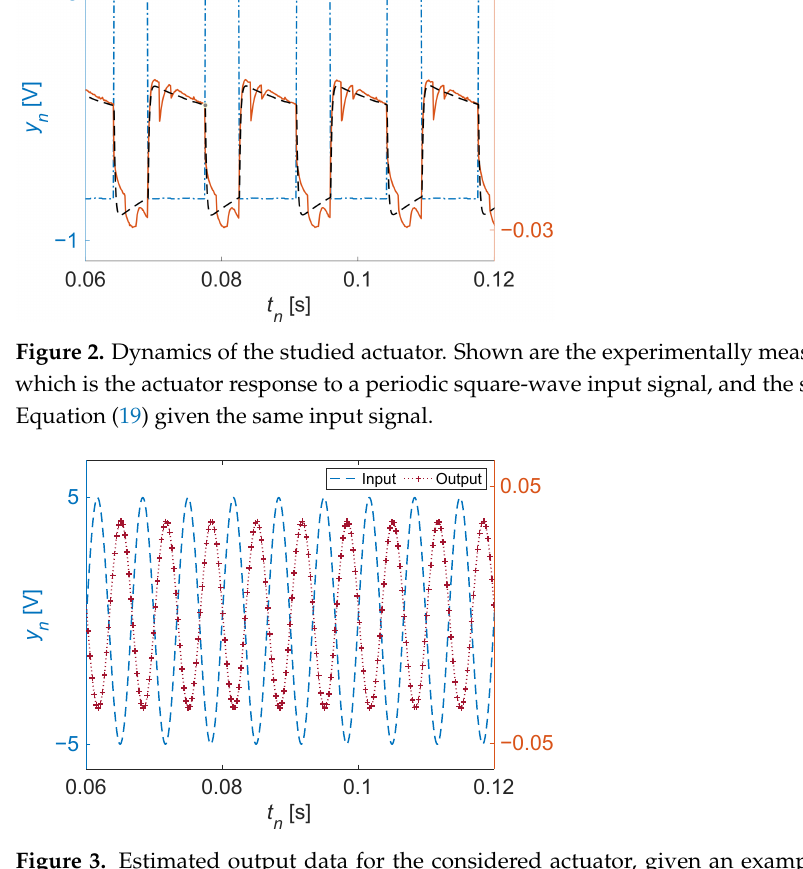
Figure 3. Estimated output data for the considered actuator, given an example input, using the generated transfer function [Equation